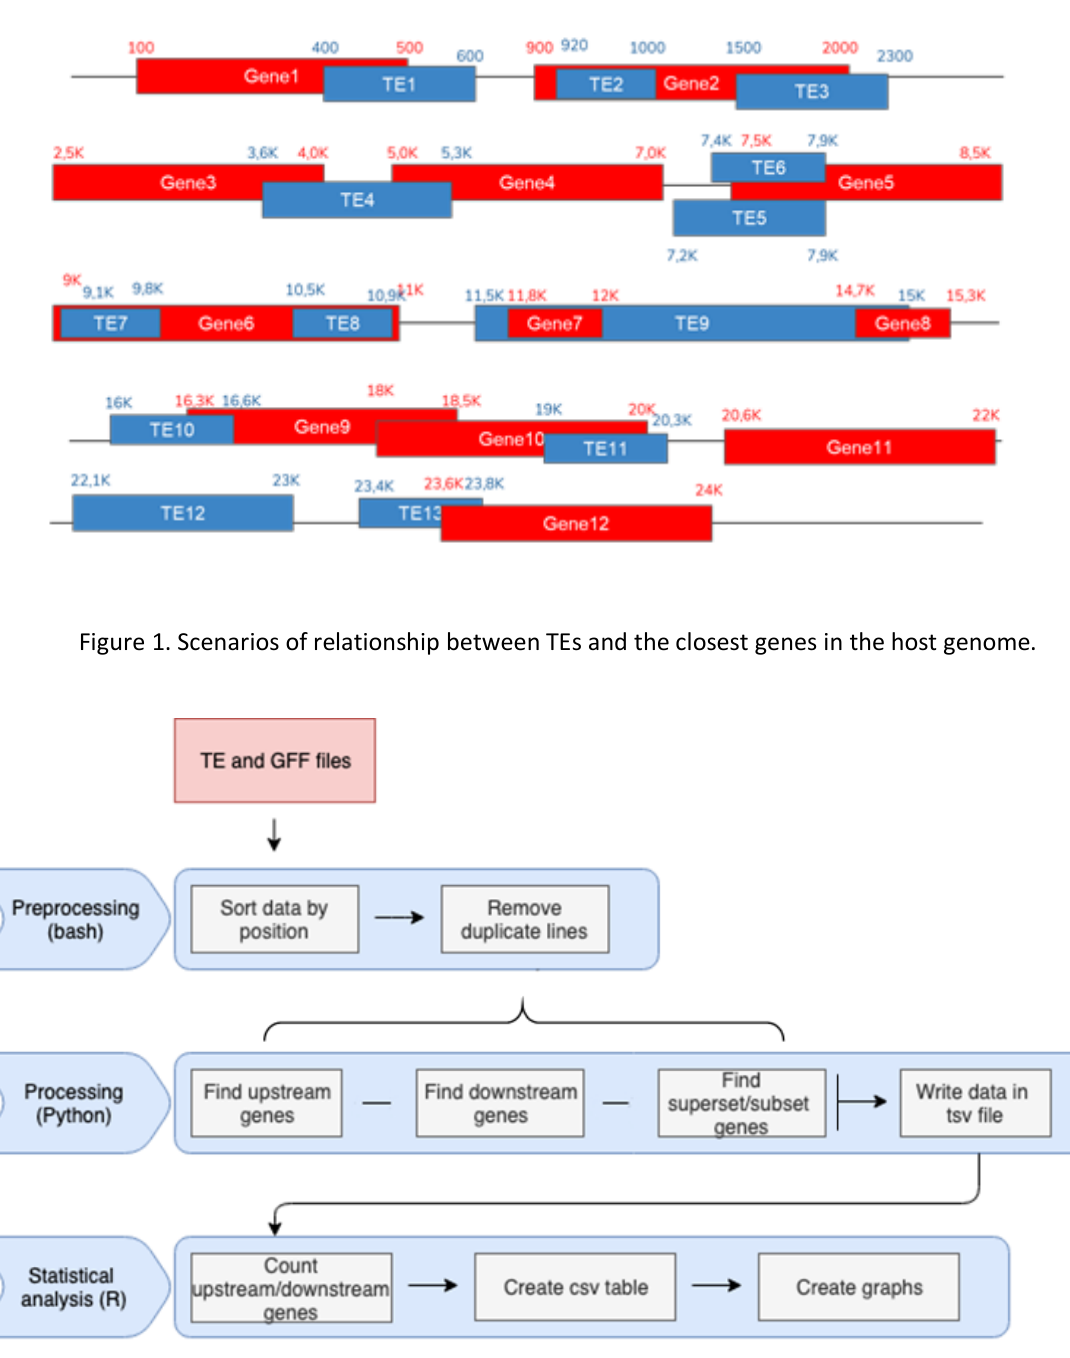
Figure 2. The workflow of the pipeline comprises three different steps: preprocessing, processing and statistical